Question: Looking at the figure, what chart type is it?
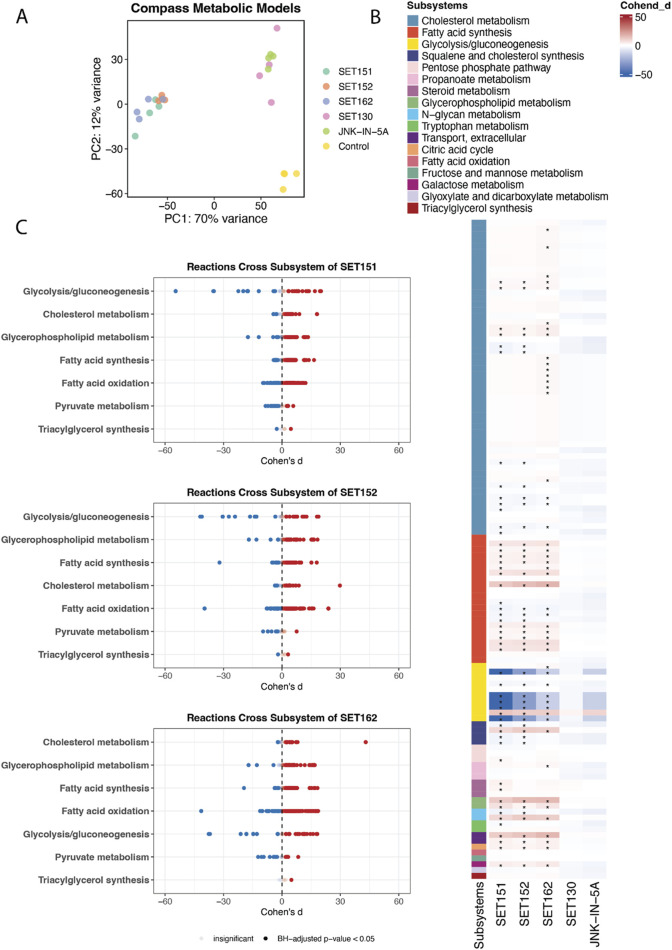
Answer: heatmap